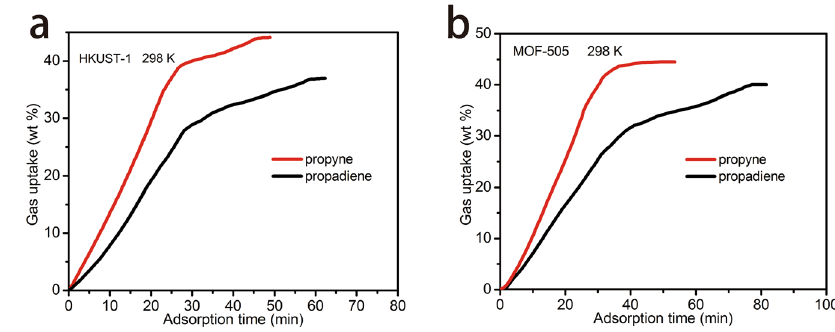
Fig. 8 Gravimetric propyne and propadiene sorption kinetics at 298 K. a HKUST-1.